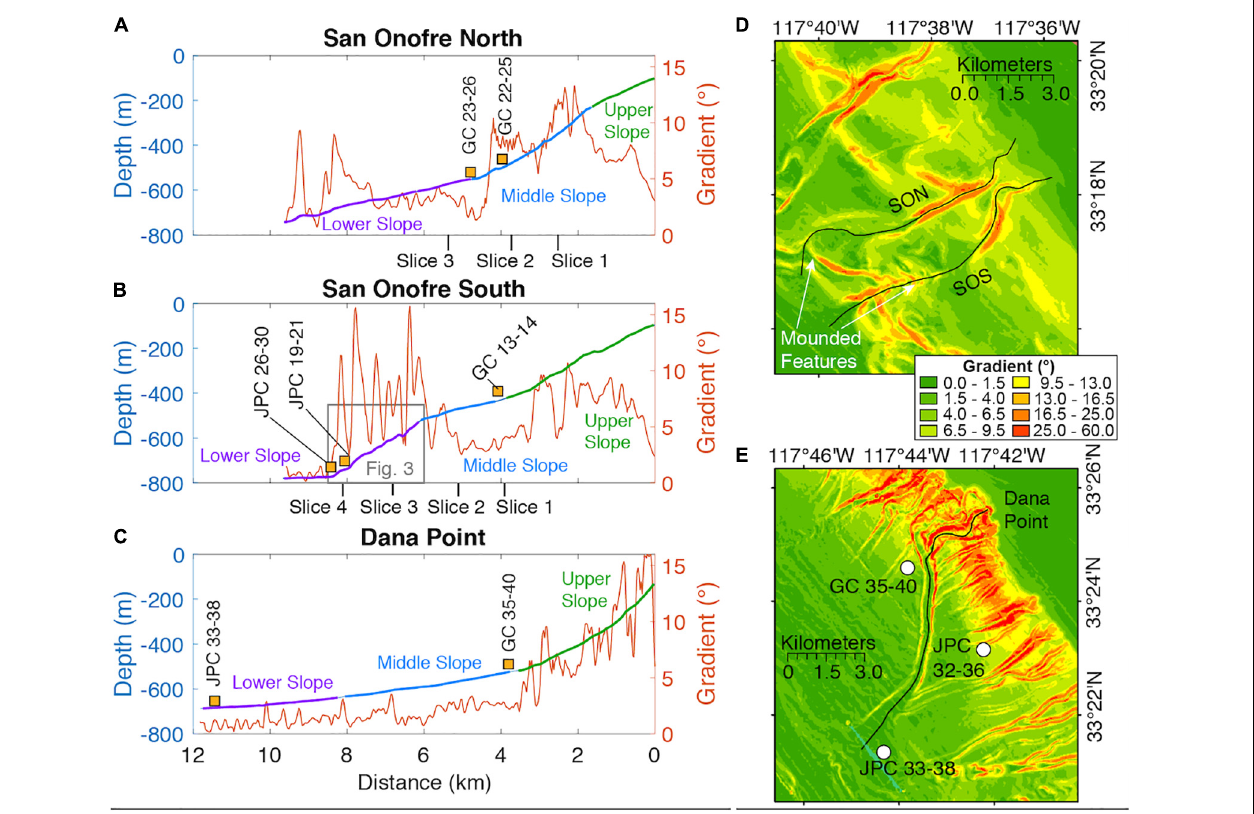
FIGURE 2 | (A–C) Bathymetric profiles of the San Onofre North, San Onofre South, and Dana Point Canyons are plotted with channel gradient. The channel profiles are subdivided into the Upper, Middle, and Lower slope. The locations of sediment cores are projected onto profiles as yellow squares. The intersections of Sparker 3D seismic slices are shown by the vertical black lines. In (B) , the location of Figure 3 is highlighted. (D,E) Gradient maps offshore of San Onofre and Dana Point. SON = San Onofre North, SOS = San Onofre South. Green colors represent gentler gradients and red colors represent steeper gradients. The bathymetric profile through the channel is shown by the black